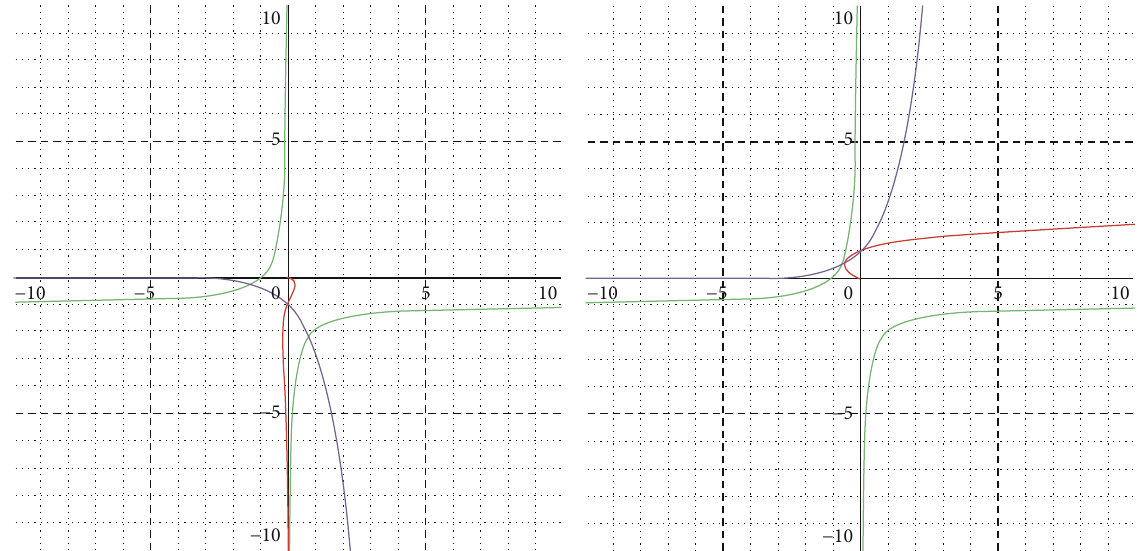
Figure 1: Graphs of the logarithmic Lambert function with B = 1 and B = − 1 . The graphs with red, blue, and gray colors are the graphs of x = f ð y Þ , x = g ð y Þ , and x = h ð y Þ ,